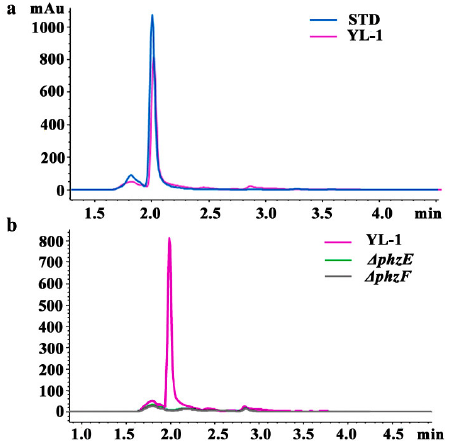
Figure 2. Reversed phase (RP)-HPLC chromatograms. An overlay of the chromatograms at 254 nm of STD sample (blue) and the final extraction step of the wild-type YL-1 (pink) ( a ), mutants Δ phzE (green), and Δ phzF (black) ( b ), using an XDB-C18 reversed-phase column (4.6 mm 150 mm, 5 μm, Agilent), is shown. Here, STD sample (blue) was used as a positive control. The samples were eluted with acetonitrile (ACN)-5 mM ammonium acetate (60:40, v / v ) at a flow rate of 0.7 mL/min. The ex- periment was repeated three times.